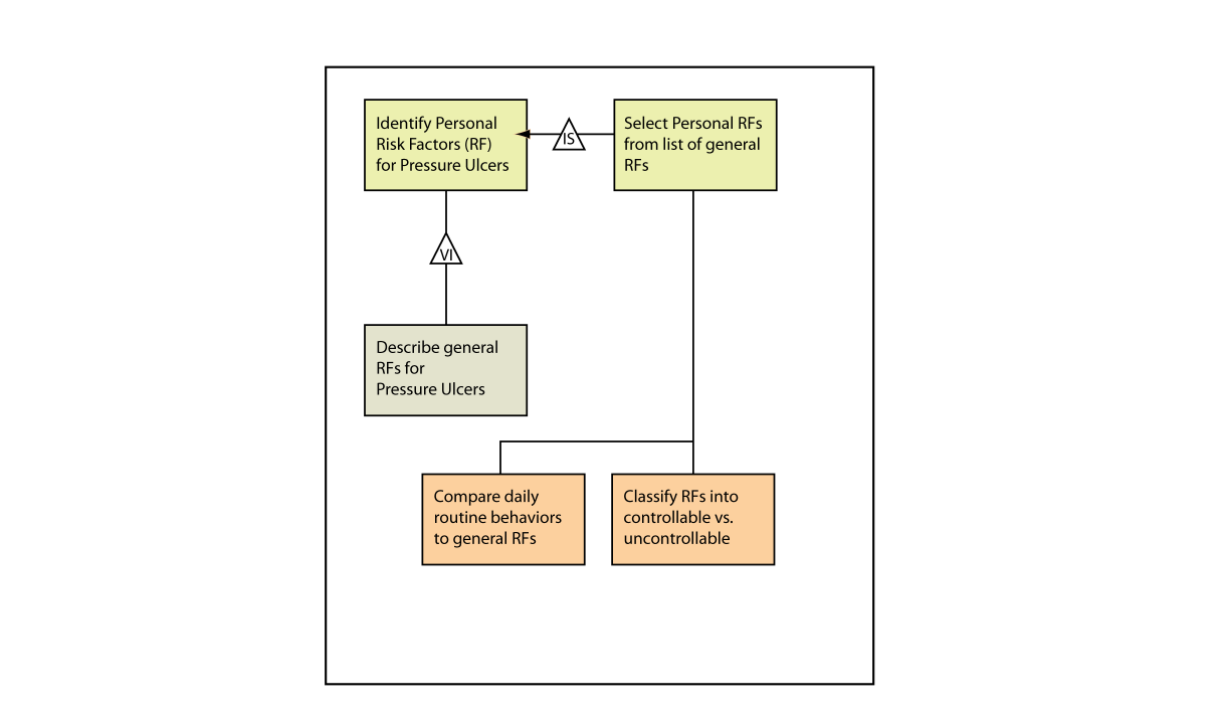
Figure 4. Example of instructional curriculum mapping. Program objective: core level. IS = intellectual skill; VI = verbal information.